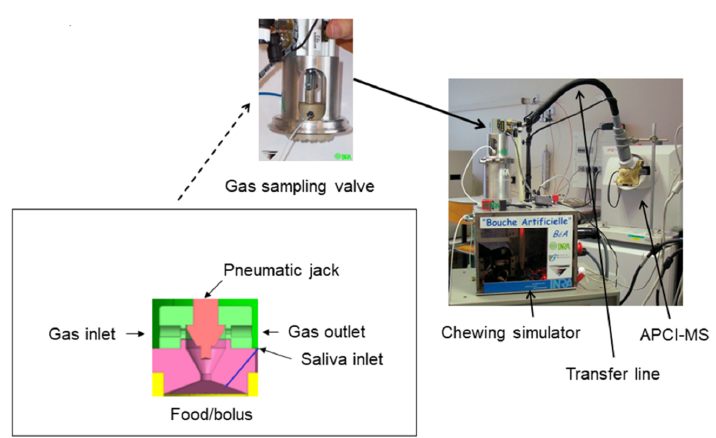
Figure 1. Chewing simulator connected to the atmospheric pressure chemical ionization mass spectrometer (APCI-MS) for online and real time analyses of aroma compound release under in vitro mastication conditions with details of the gas sampling valve. Table 3. In vivo aroma compound release. Fisher statistics from Analyses of Variance (ANOVA) of the temporal aroma compound release parameters. Only significant results ( p < 0.05) are reported.